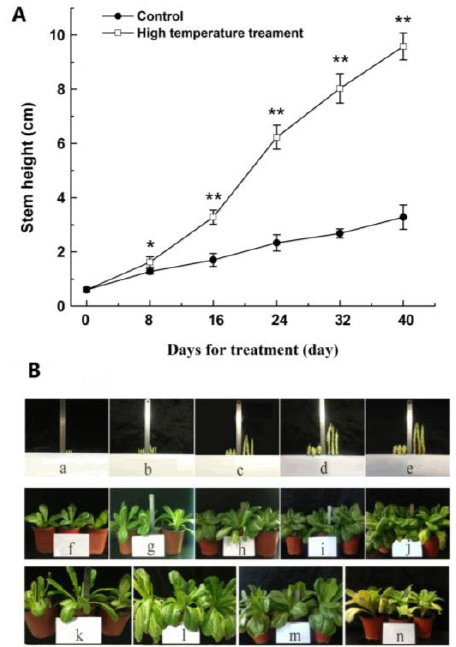
Figure 1. Change of stem height in lettuce after high temperature treatment of 33/25 °C. ( A ) Changes of stem length under 20/13 °C (day/night) (control) and 33/25 °C (day/night) treatment for 40 days. The data (mean ± SD) are the means of three replicates with standard errors shown by vertical bars, n = 9. * and ** indicate significant difference at p < 0.05 and p < 0.01 by Tukey’s test, respectively. ( B ) The phenotypes of lettuce under 20/13 °C (day/night) (control) and 33/25 °C (day/night) treatment for 40 days. (a–e) Stem growth after different temperature treatment for 0, 8, 24, 32 and 40 days (control on left and high temperature treatment on right). Representative images of plants under control (g–j) and high temperature treatment (k–n) for 8, 24, 32 and 40 days, and (f) plant growth at Day 0.